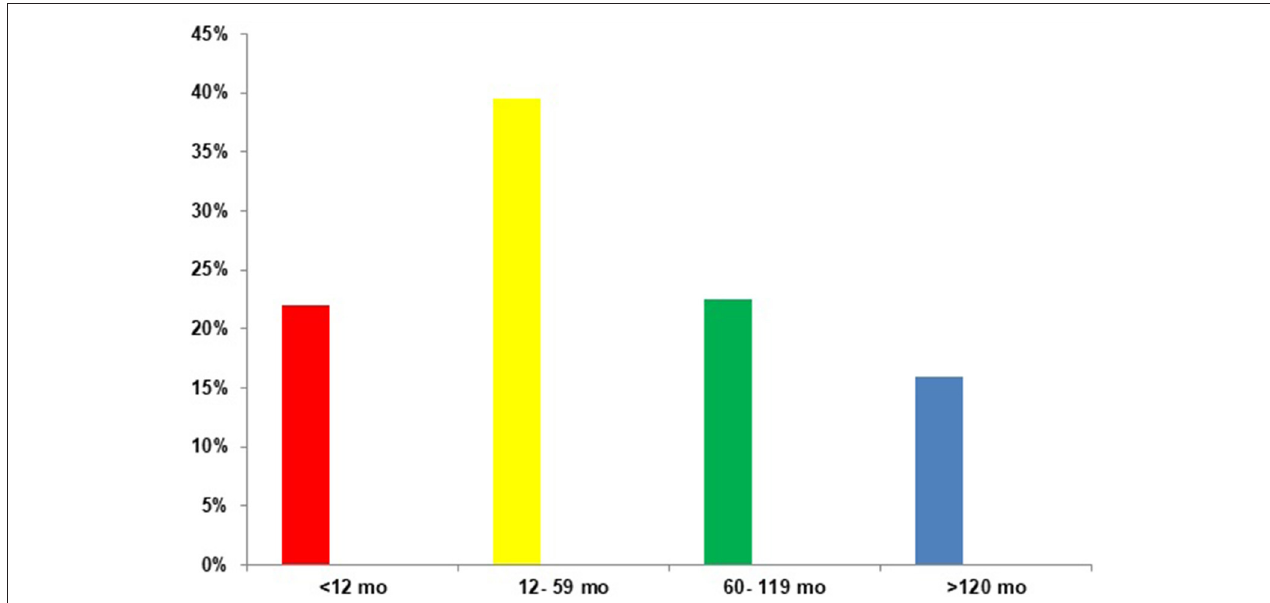
FIGURE 1 | Distribution of the included population according to age ( n =